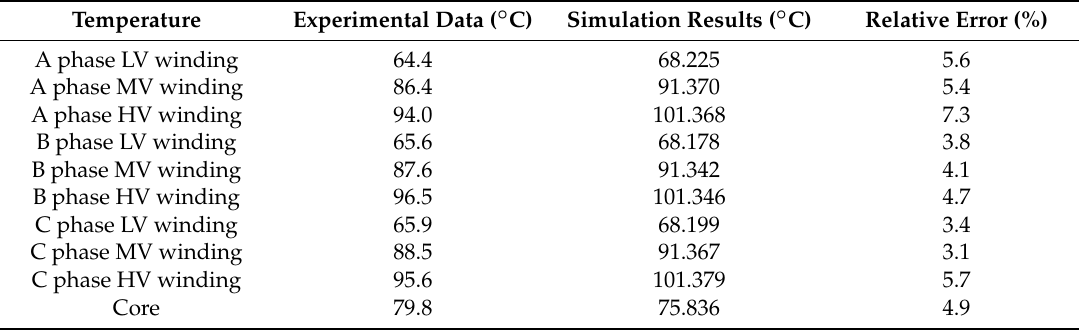
Table 5. Comparison between experimental data and simulation